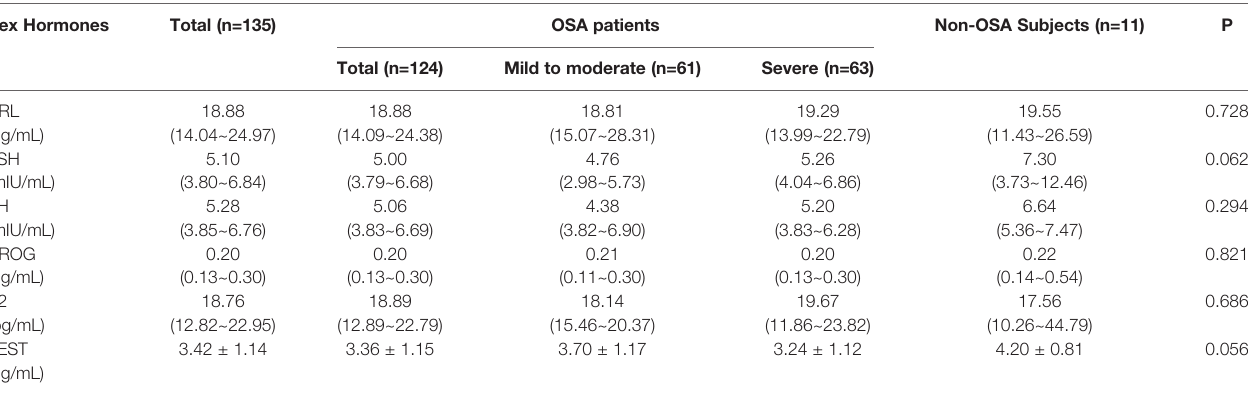
TABLE 2 | Sex hormone test data of the population included in the study.